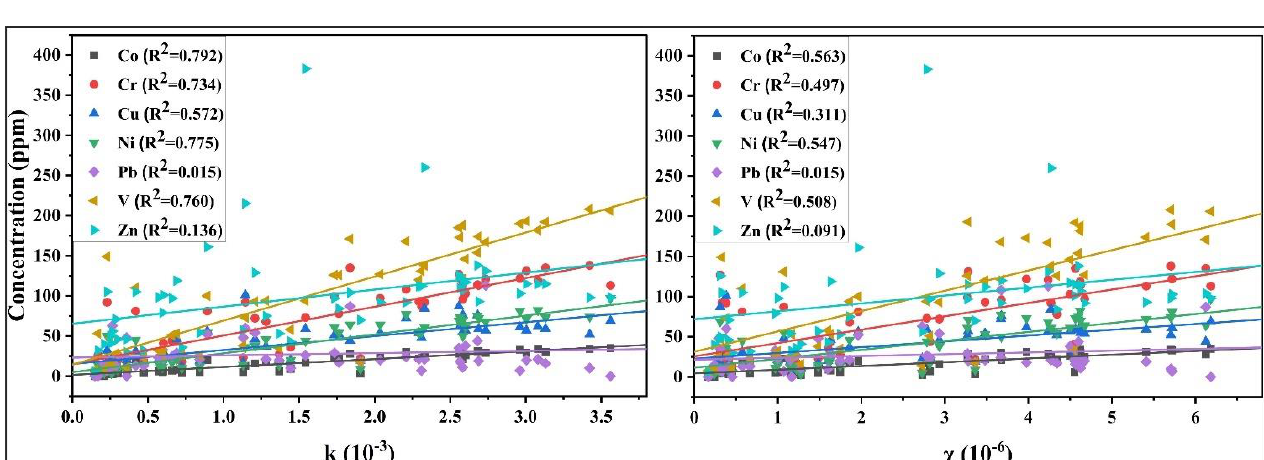
Figure 9. Scatter plot of PTEs with Al, Fe, Mn, and Ti.